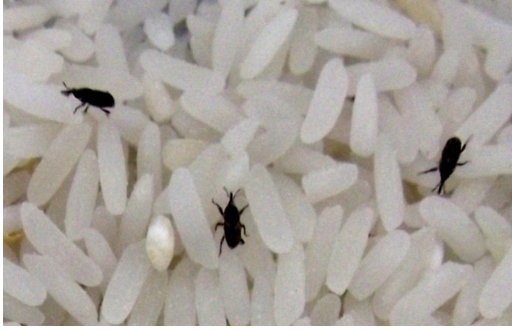
Fig. 2. A snapshot of rice stock infested with rice